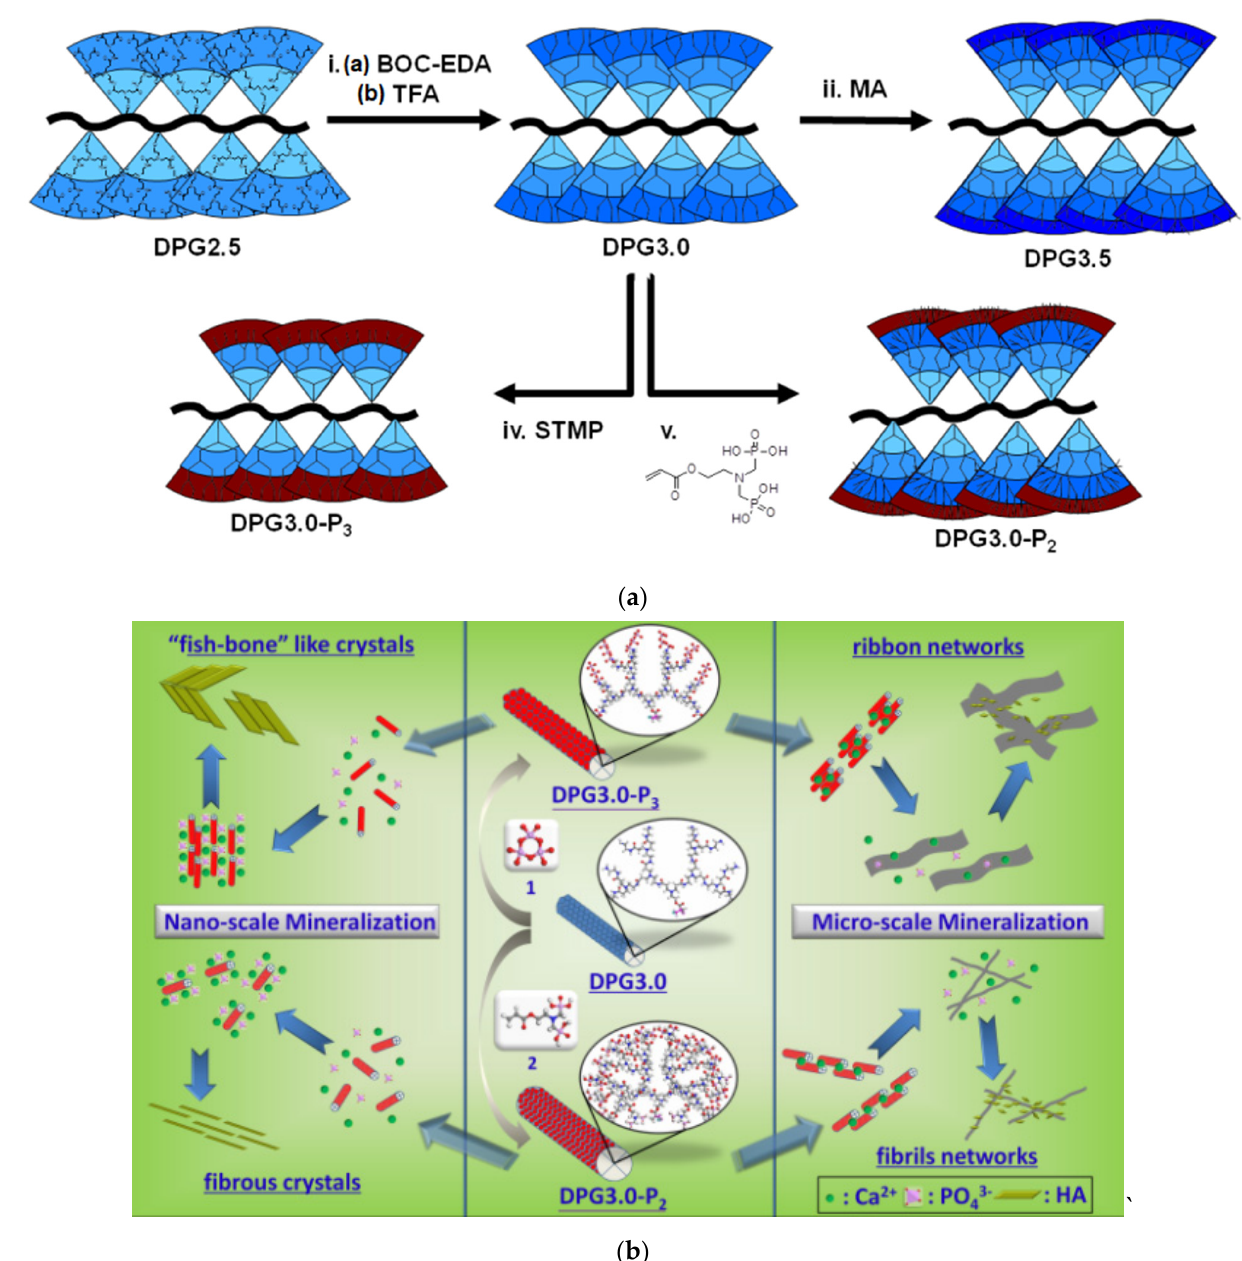
Figure 13. ( a ) Schematic illustration of the syntheses of dendronized PAMAMs ( b ) Phosphorylation of dendronized PAMAMs and their directed HA biomineralization on both nano- and micro-scales. Both were reproduced under permission from [170]. Copyright: ROYAL SOCIETY OF CHEMISTRY .